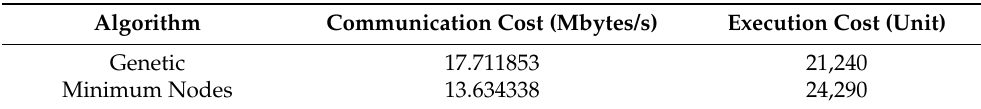
Figure 2. Generated sample deployment alternative for 1070 microservices on three nodes using a genetic algorithm. Table 3. Total execution and communication costs according to Genetic and Minimum Nodes